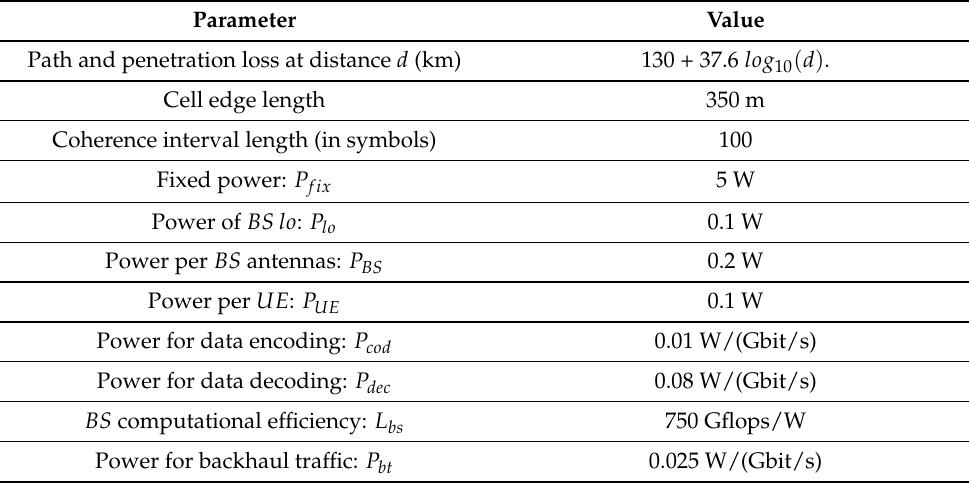
Table 4. Simulation